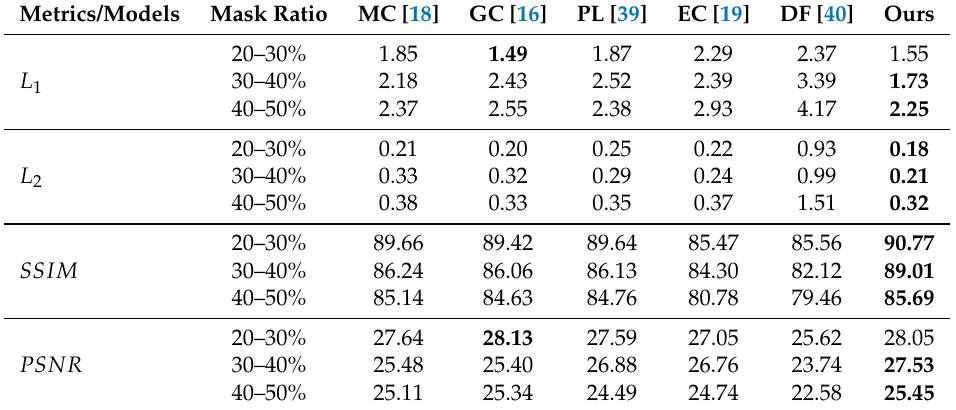
Table 3. Quantitative comparison on CelebA-HQ dataset